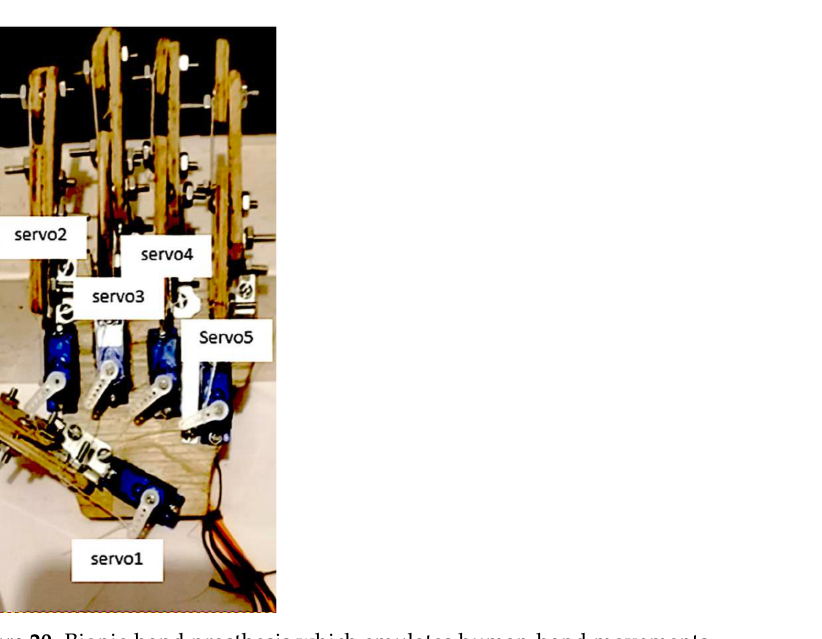
Figure 20. Bionic-hand prosthesis which emulates human-hand movements. Real environment operational test is carried out by performing 90 random move- ments, taken from the previously described in Section 4.2. Where 84 movements were correctly replicated and 6 were incorrectly performed, obtaining a 93.3% of assertiveness and 6.6% of error. This is according with the efficiency percentages obtained in the training and